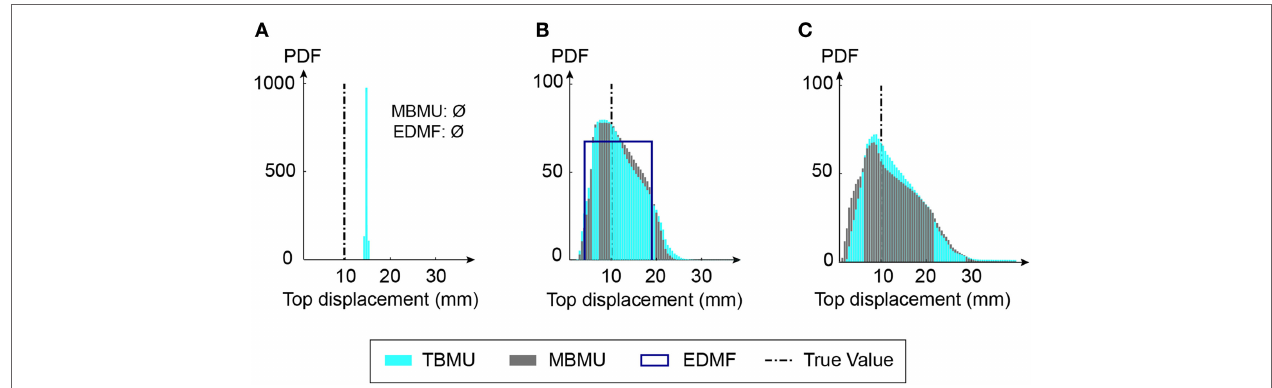
FIGURE 11 | Comparison of predicted absolute maximum top displacements during an aftershock for tested identification scenarios. If model errors are ignored (S 1 in Table 2 ), error-domain model falsification (EDMF) and modified Bayesian model updating (MBMU) indicate that the wrong model class is used (A) . The vertical axis (probability density function) for measurement uncertainty (A) is increased for better readability. (B) Predefined uncertainty. (C) Parameterized uncertainty.